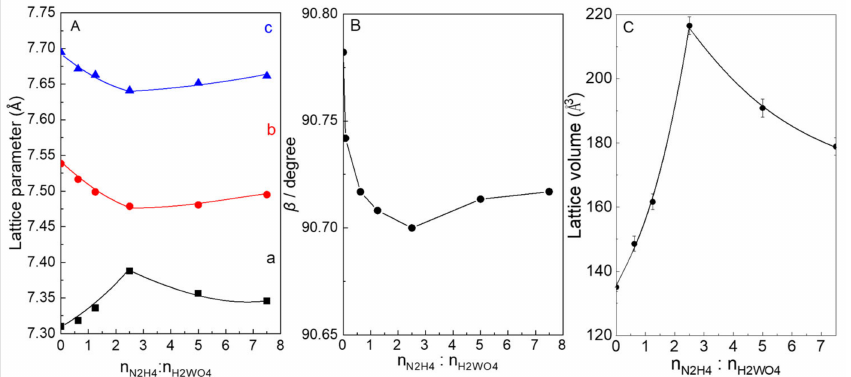
Figure 4. ( A ) Plots of lattice parameters of (a), (b), and (c) versus the addition of N 2 H 4 . ( B ) Plots of β versus the addition of N 2 H 4 , and ( C ) Lattice volumes of N 2 -intercalated WO 3 samples prepared with addition of N 2 H 4 . The lattice volume (V) was calculated according to equation: V = abc (sin β ), β is the angle between a and c.